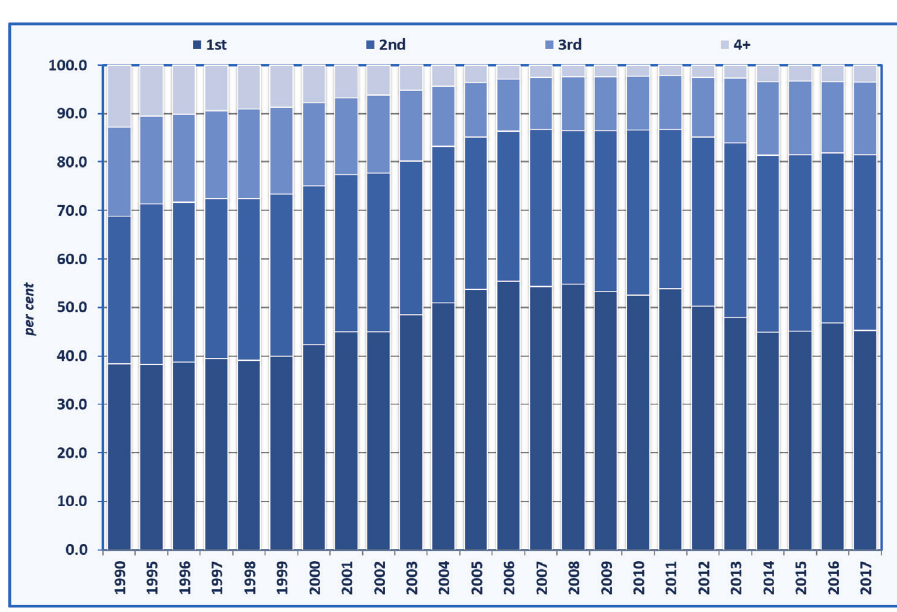
Figure 8. Dynamics of the distribution of births by birth order, 1990-2017 (%). Source: according to SSC